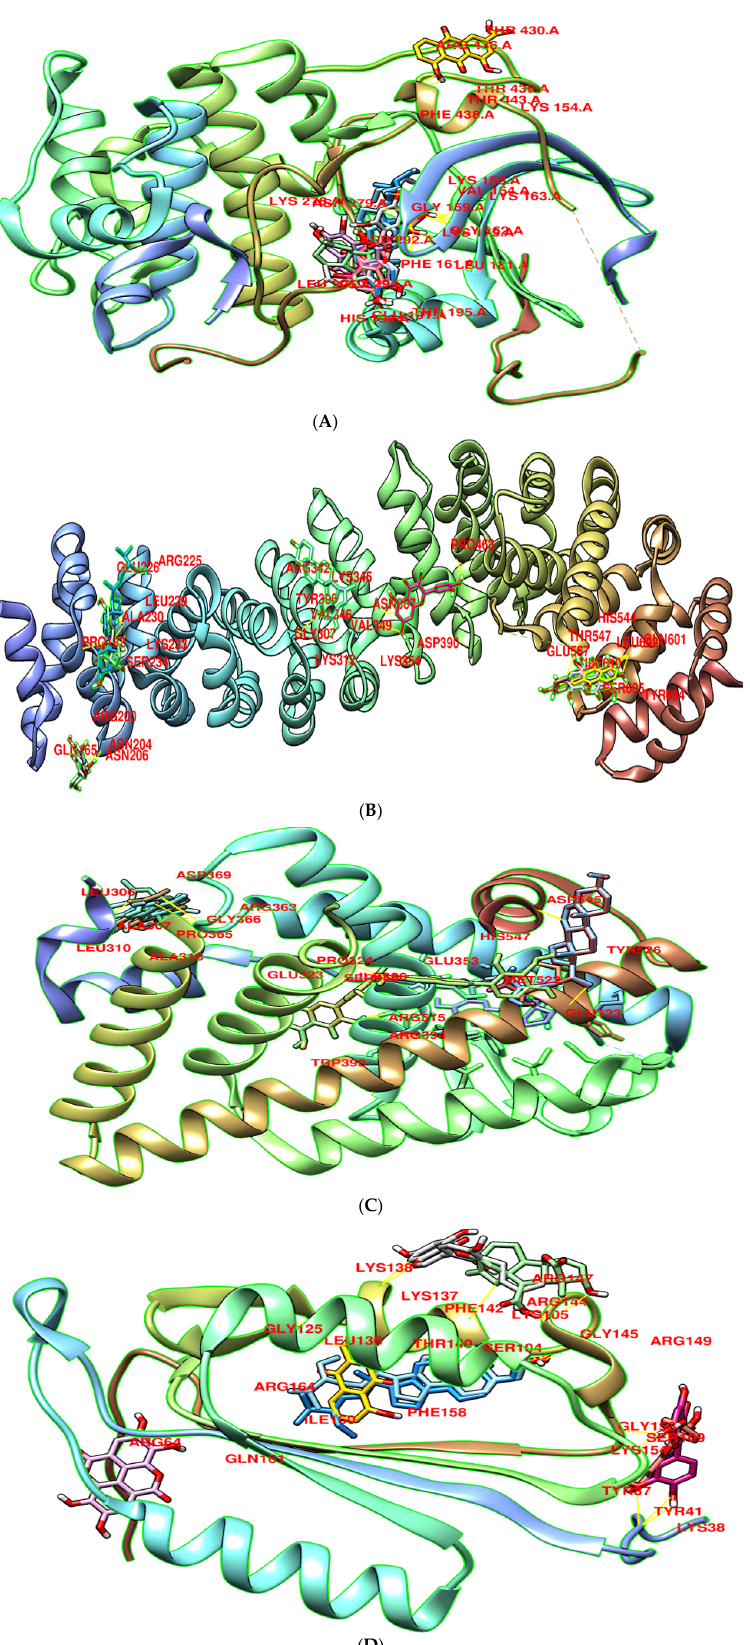
Figure 9. The binding site residues with the four proteins are shown in the docking complex of four targets with their best binding components: ( A ) AKT1; ( B ) CTNNB1; ( C ) ESR1; ( D )